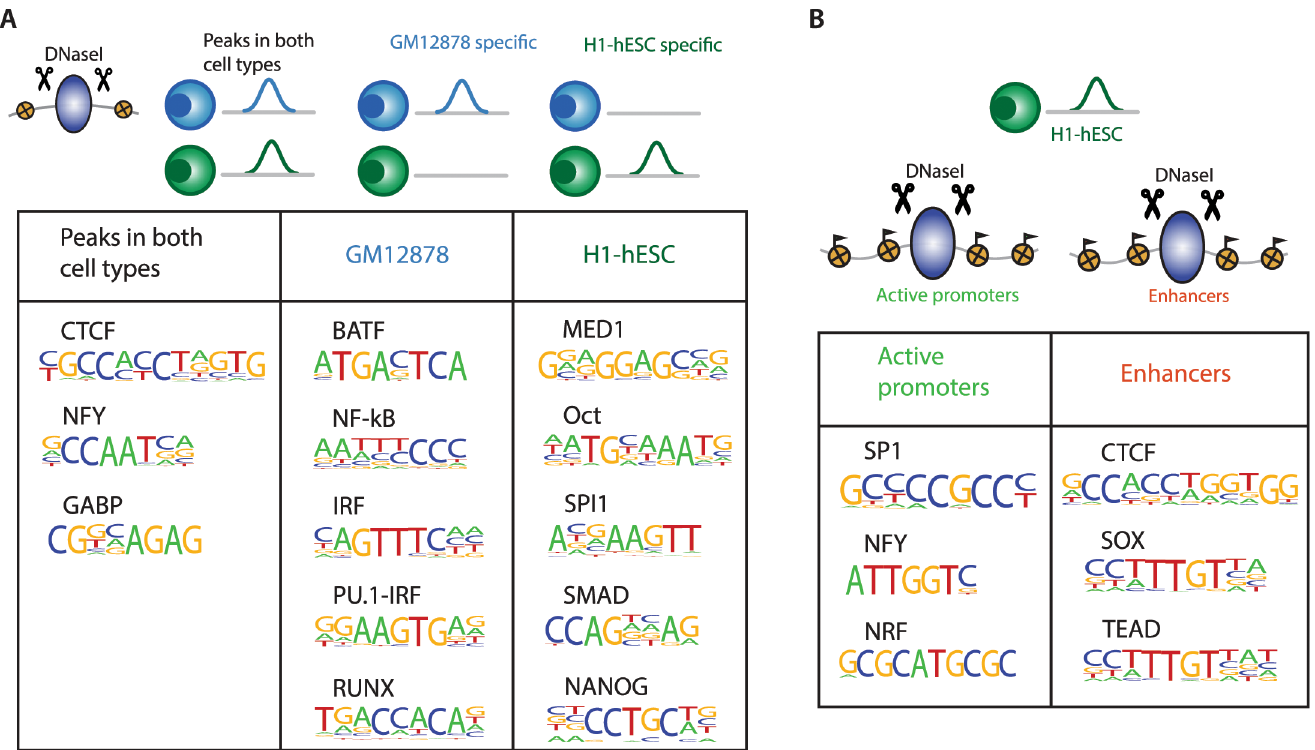
Fig 7. Context determinants of DNase binding signals. (A) DNase peaks across cell types show significant differences in the underlying sequence preferences depending on the context. DNase peaks that are common to both GM12878 and H1-hESC cell lines show strong preferences for either insulator proteins (CTCF) or promoter associated regulators (NFY) whereas again cell-type specific peaks show preferences for cell-type specific regulators (BATF, IRF, RUNX in GM12878 and OCT, SMAD, NANOG in H1-hESC). (B) The chromatin context of a DNase peak also defines a context for specific binding preferences. DNase peaks in active promoter regions are associated with NRF, SP1 and NFY motifs whereas peaks in the enhancer regions are associated with CTCF, SOX and TEAD motifs.